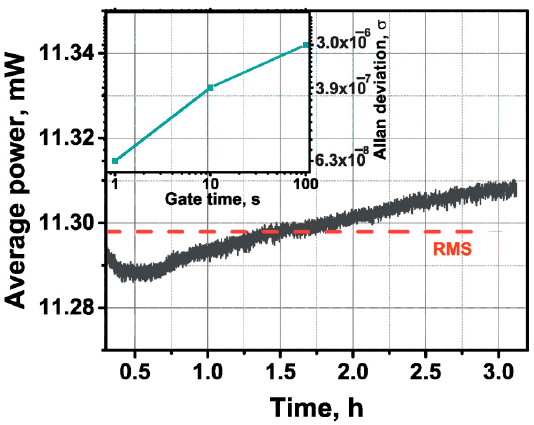
Figure 10. Average output of optical power during the measurement. Inset: Allan deviation of the repetition rate in a 1 × 10 2 s time interval.